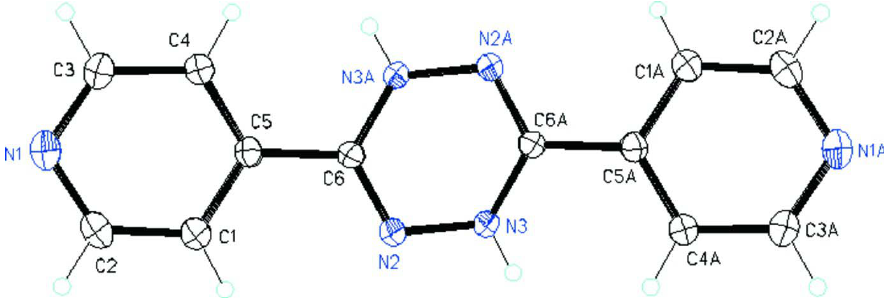
The molecular structure of the title compound with 30% displacement ellipsoids. Symmetry code for the atoms designated with A: -1/2 - x , 1/2 - y , z